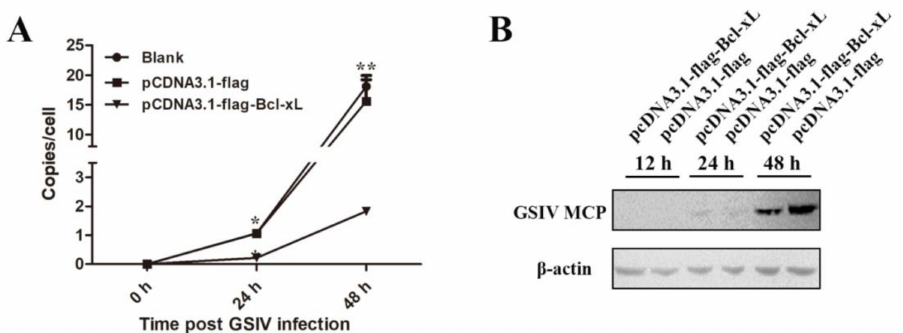
Figure 5. Effect of AdBcl-xL overexpression on the GSIV major capsid protein (MCP). ( A ) MCP gene copies in normal GSM cells, pCDNA3.1-flag-transfected GSM cells, or pCDNA3.1-flag-Bcl-xL- transfected GSM cells as detected using ddPCR at 6, 24, and 48 h post GSIV infection. ( B ) Proteins were extracted from GSM cells transfected with pCDNA3.1-flag-Bcl-xL and pCDNA3.1-flag at 0, 24, and 48 h post GSIV infection and analyzed by Western blotting. β -actin was used as a reference. * p < 0.05, ** p <